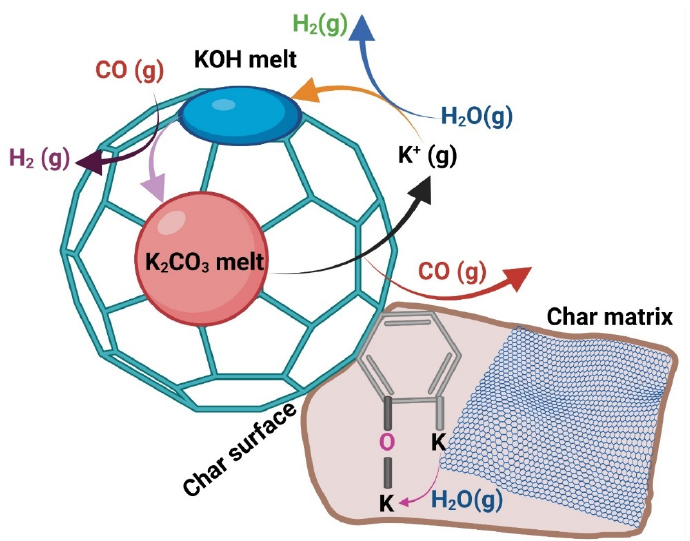
Figure 6. Mechanism of the interaction of potassium compounds with the carbonaceous char matrix during steam gasification [91,94].